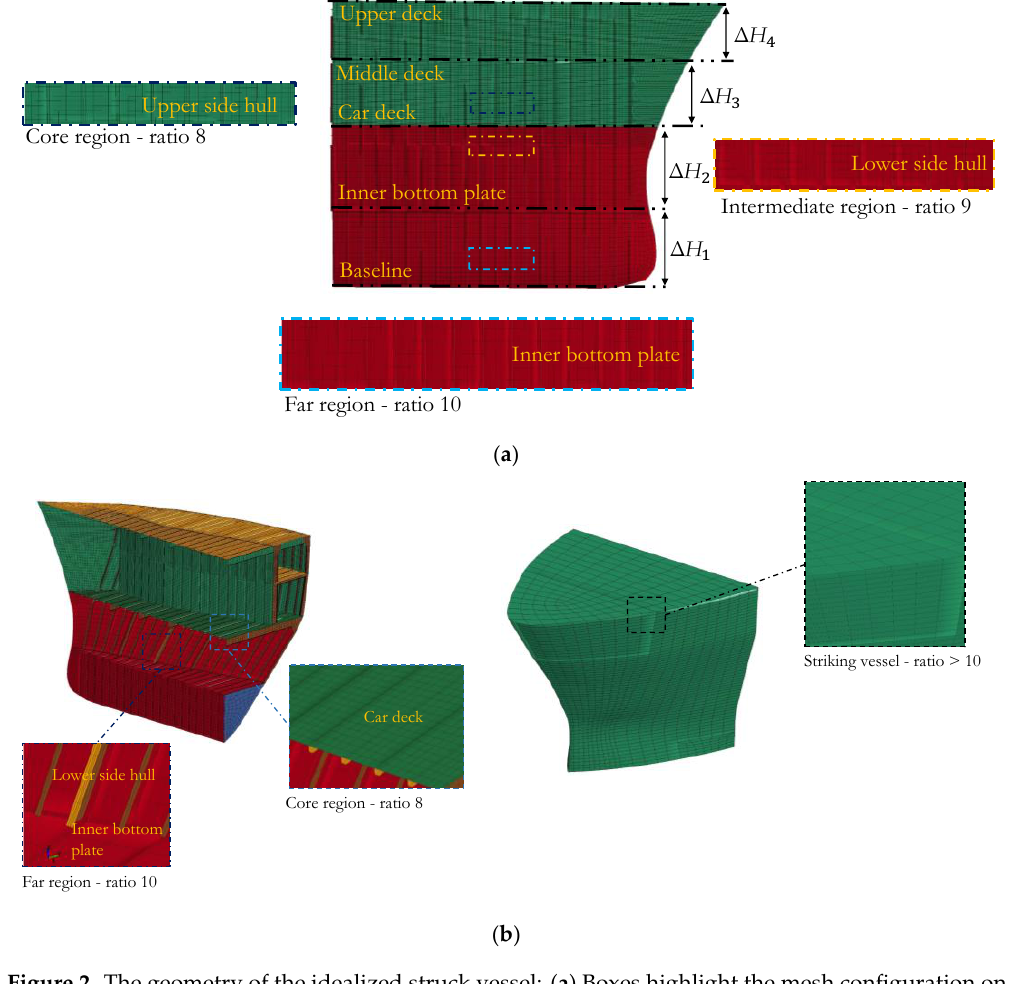
Figure 2. The geometry of the idealized struck vessel: ( a ) Boxes highlight the mesh configuration on the side hull, and ( b ) Detail of meshing on the inner structure and the striking vessel.